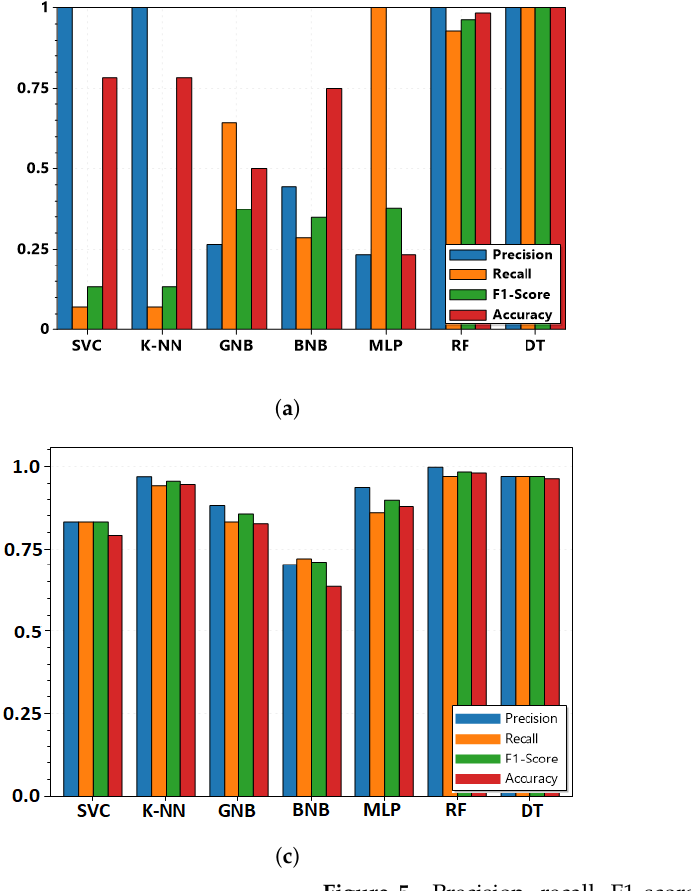
Figure 5. Precision, recall, F1 score, and accuracy obtained based on the pignistic score from disjunctive-based DS fusion performed from probability scores from different classifiers with cyber- physical features combined using FL architecture in Figure 3 for ( a ) UC1; ( b ) UC2; ( c ) UC3; and ( d ) UC4 with 30 s polling interval and 10 polled outstations.